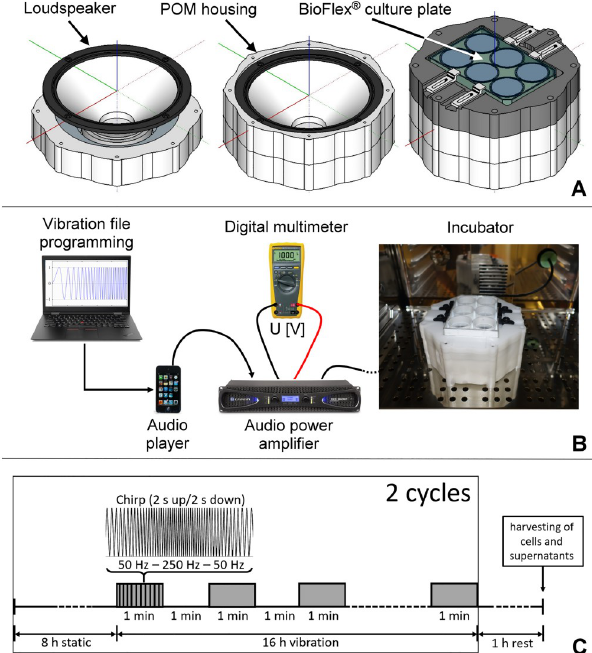
Fig 1. Construction of the bioreactor. A custom-made POM housing, designed using a 3D CAD software, accommodated the BioFlex plate (A). The schematic diagrams depict the assembly of all the components of the bioreactor (B) and the vibration pattern to which the cells were exposed to